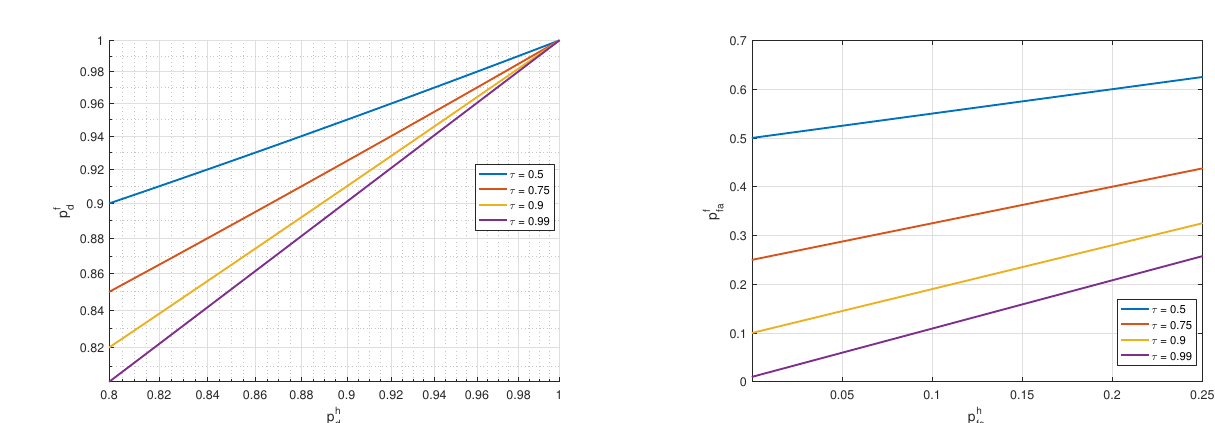
for various values of τ d